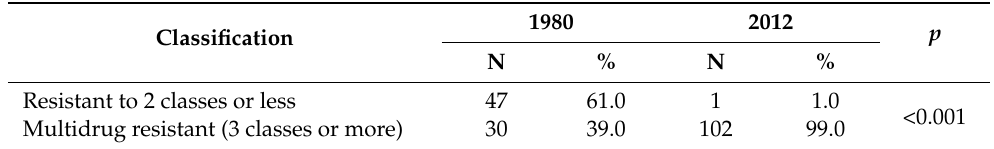
Table 4. Frequency of S. hyicus strains presenting multidrug resistance to antimicrobials according to isolation